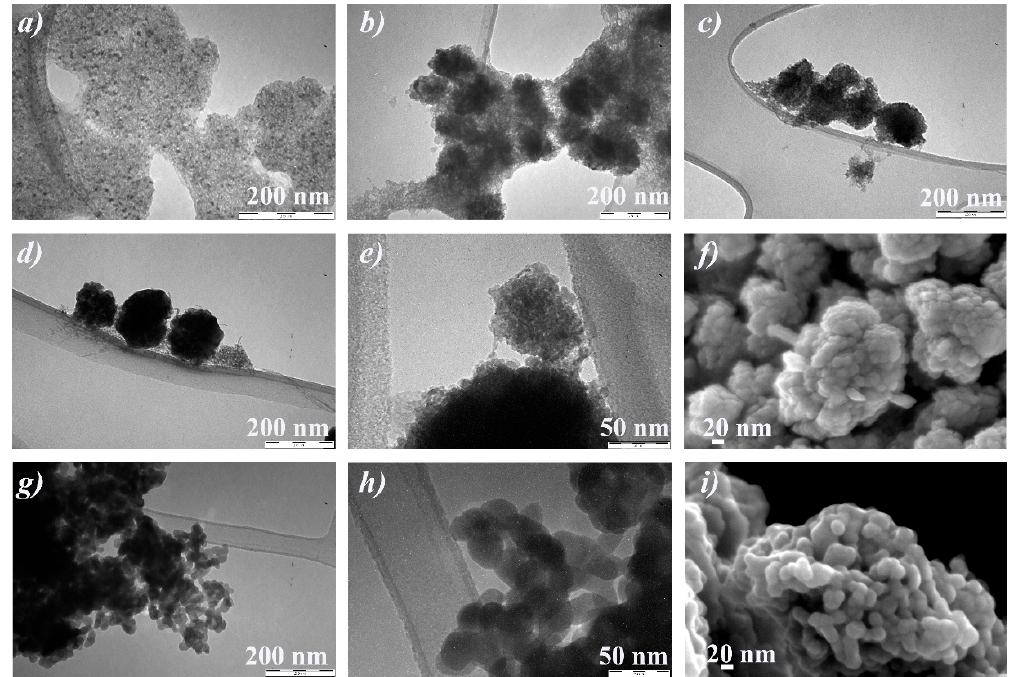
Figure 8. TEM images of samples observed after aging in water at RT for the following times: ( a ) One week, ( b ) two weeks, ( c ) two months, ( d , e ) seven months. ( g , h ) TEM images of the sample calcined at 500 °C for 3 h. FE-SEM images of the samples: ( f ) After aging in water at RT for seven months, ( i ) calcined at 500 °C for 3 h.